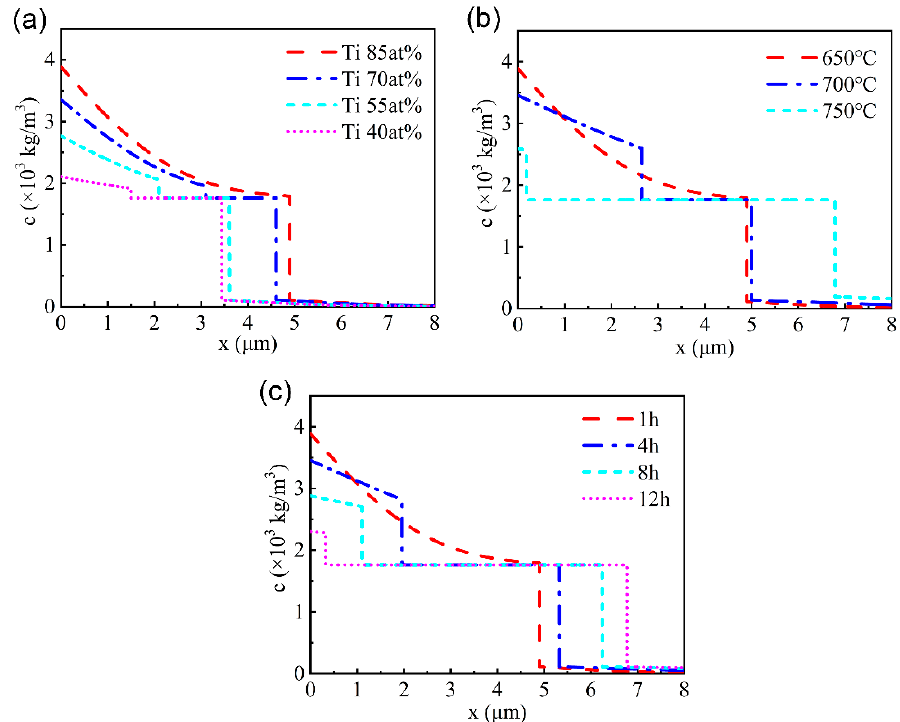
Figure 3. ( a ) The distribution of the Ti atoms along the cross-sectional profile after thermal diffusion at 650 °C for 1 h; ( b ) the distribution of the Ti atoms along the cross-sectional profile after thermal diffusion for 1 h at different temperatures; ( c ) the distribution of the Ti atoms along the cross-sectional profile after thermal diffusion at 650 ℃ for different durations.